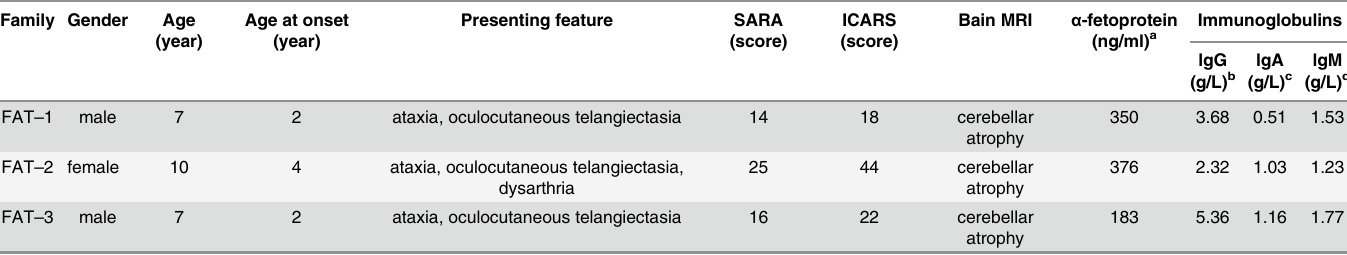
Table 1. Clinical and laboratory features of each AT